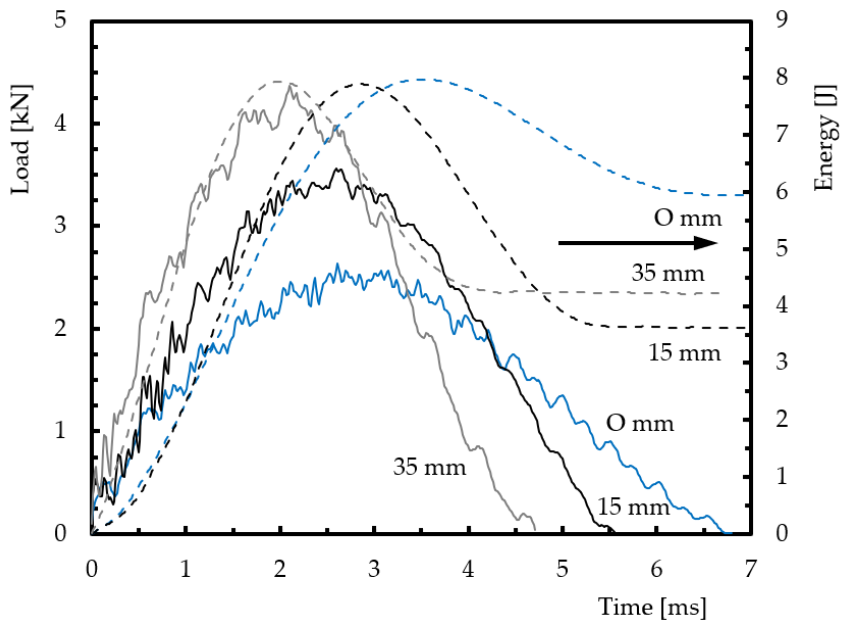
Figure 3. Effect of the impact point on load – time and energy – time curves obtained with an energy of 8 J and for repaired specimens.